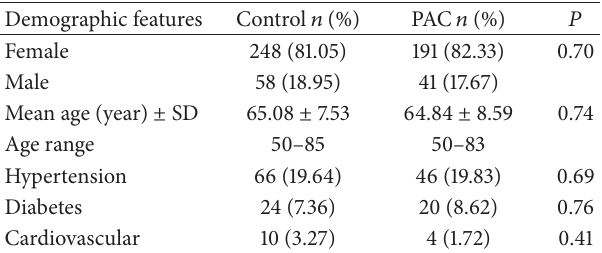
Table 1: Demographics of study participants.